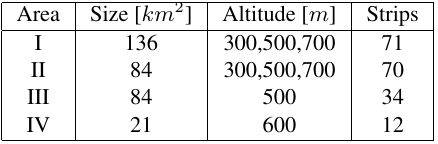
Table 1: Summary of the